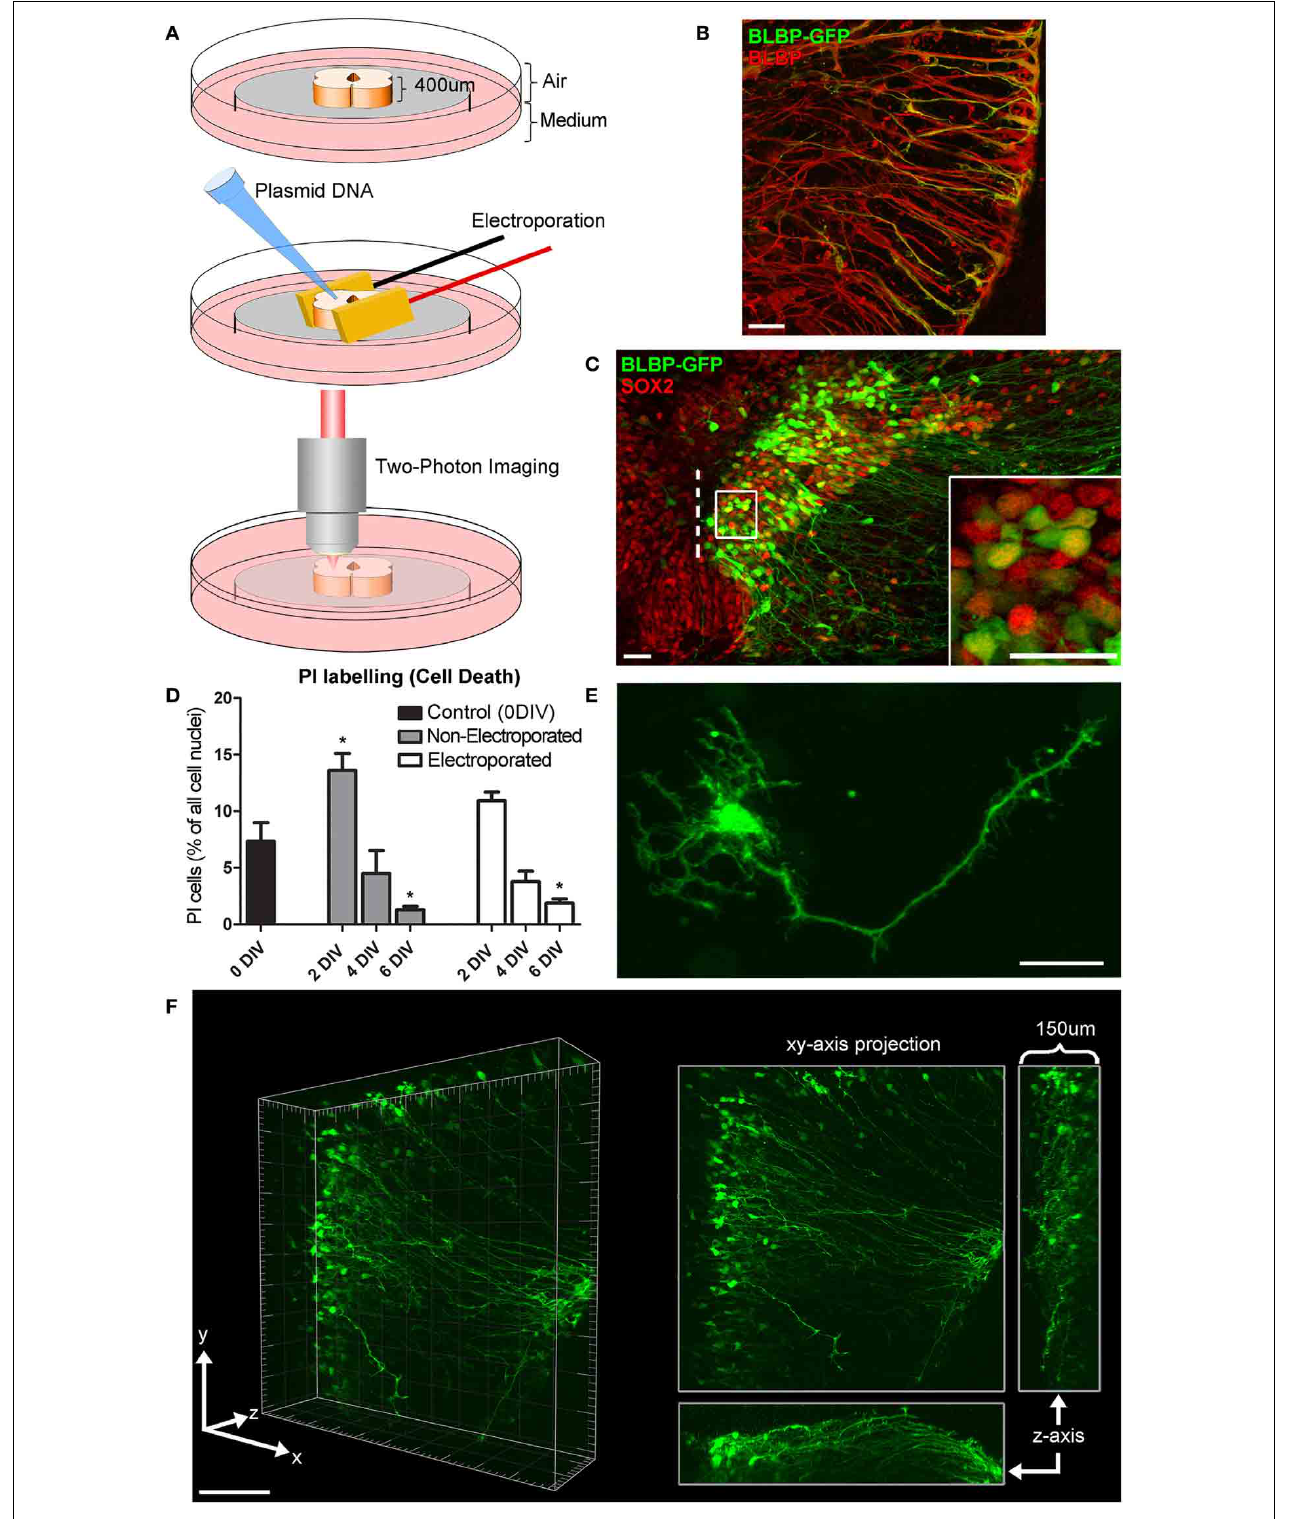
FIGURE 1 | Organotypic spinal cord slice culture and transfection with a BLBP-GFP plasmid. (A) 400 µ m thick spinal cord slices are electroporated and imaged in a 35mm dish using two-photon microscopy. For simplicity, only the spinal cord itself is shown in this schematic, although the